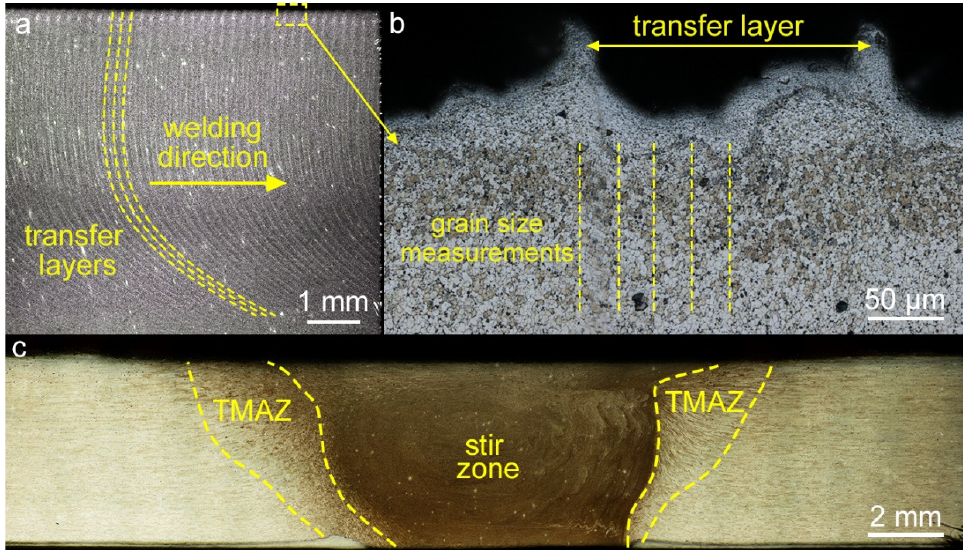
Figure 4. Metallographic images of stir zone in a longitudinal section ( a ) and the same at a higher magnification ( b ) and cross ‐ section image of the specimen ( c ).